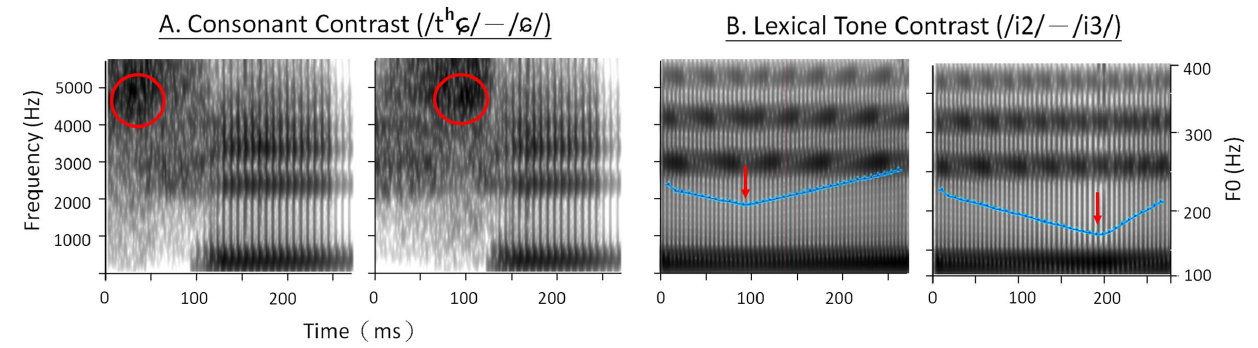
Figure 1. Spectrograms of Mandarin speech stimuli used in the study. (A) The consonant differ only in the time at which maximum amplitude is reached during the initial frication portion (marked with red circles); (B) The lexical tone differ only in the pitch contour as reflected by the turning point of the fundamental frequency (F0) (blue lines and marked with red arrows).